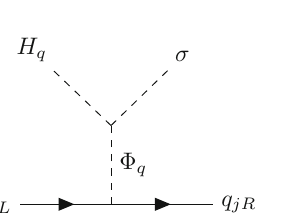
Table 2 Vector like fermions and their transformation properties of the PQ-symmetry under the DFSZ type-I seesaw model, where C = L , R